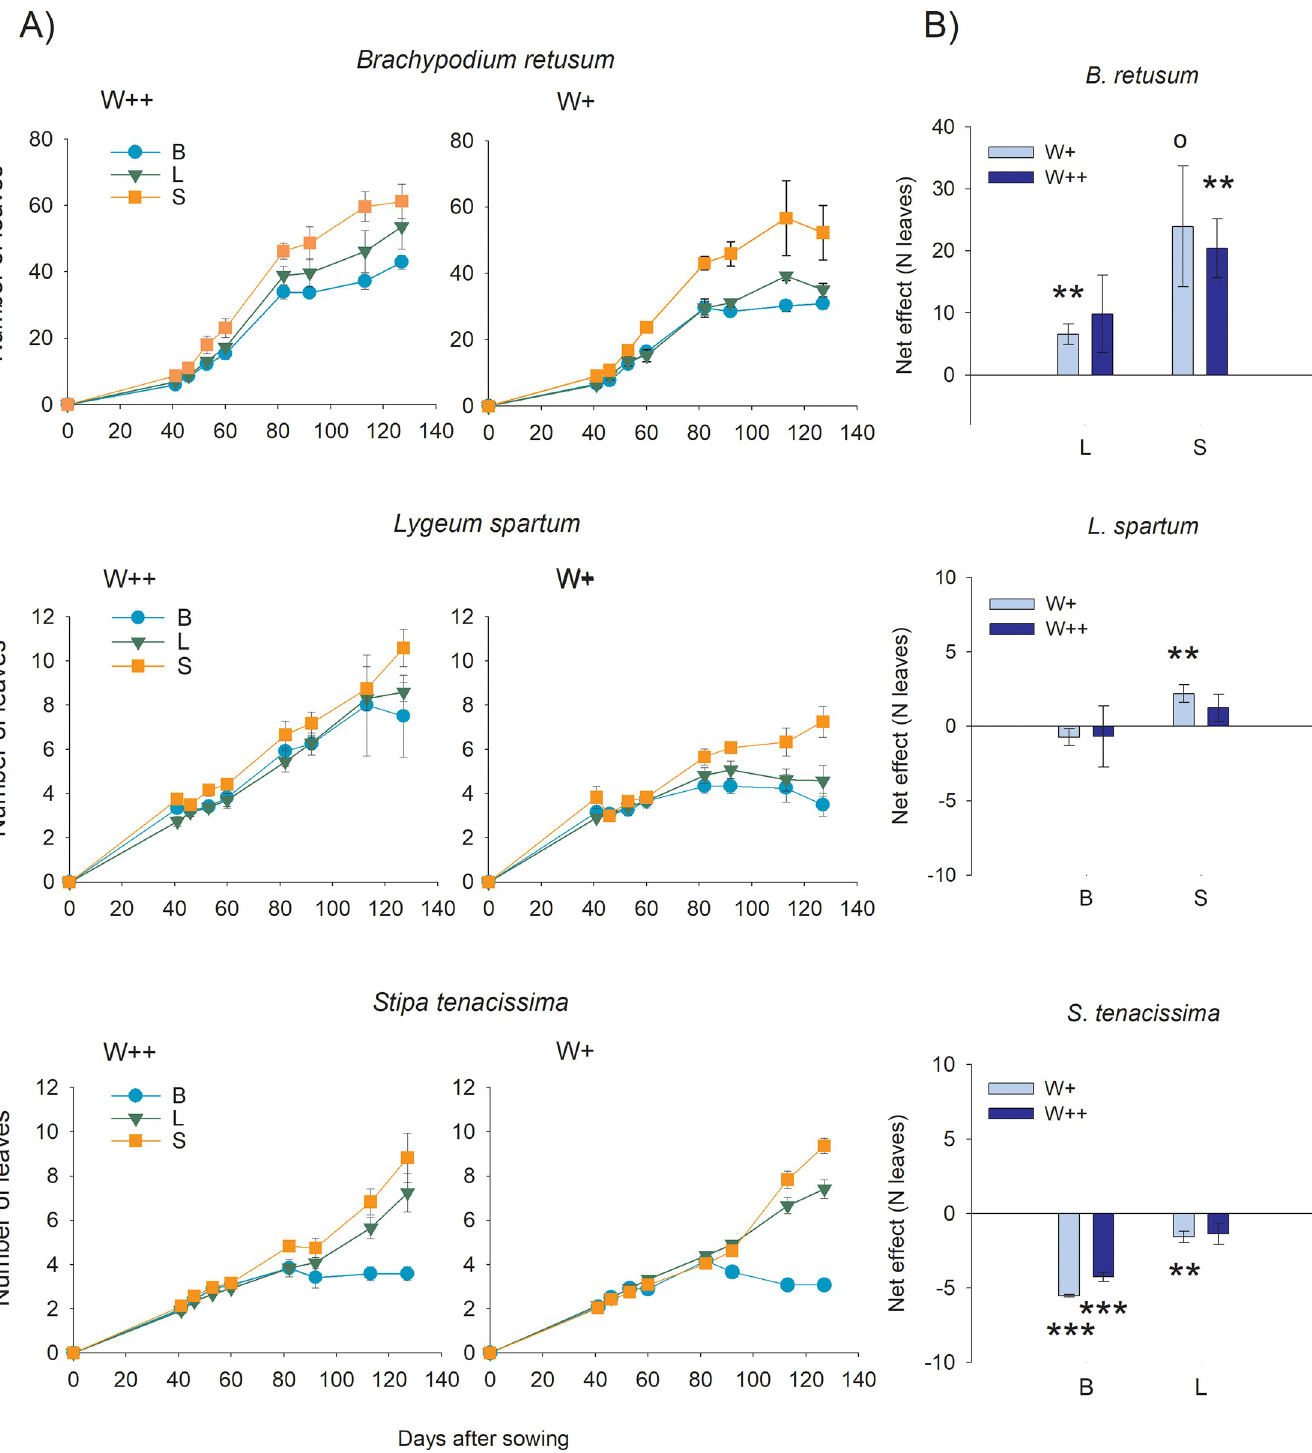
Fig 2. Pairwise interaction effect on the plant number of leaves. A) Average ( ± 1 SE) number of leaves for the three target species as a function of the accompanying species: B ( B . retusum , light blue circles); L ( L . spartum , green triangles); S ( S . tenacissima , orange squares) and the watering regime applied (W++, frequent watering; W +, reduced watering). B) Difference (net effect) in the number of leaves per plant between the bi-specific cultures and the average of the respective monospecific cultures, for the whole studied period (140 days) for each target species. Asterisks and empty circles represent, respectively, significant and marginally significant deviations of net effects from zero (two-tailed Student’s one-sample t-tests): p < 0.001 ( ��� ); p < 0.01 ( �� ), p < 0.05 ( � ), and p < 0.06 (˚); n = 4. Note the change in Y axis scaling.